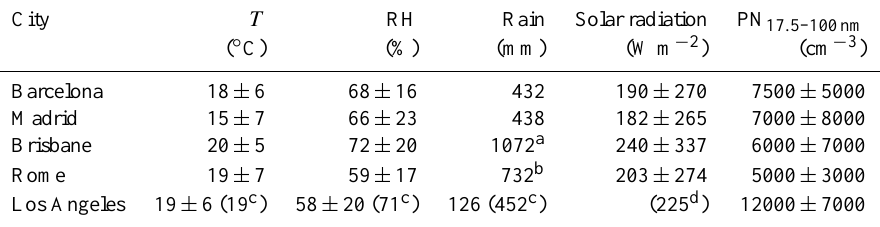
Table 1. Average annual meteorological parameters for each site during the respective study periods. Due to the reduced data availability in LA, values in parentheses represent annual values provided by NOAA or NASA. City T RH Rain Solar radiation Barcelona